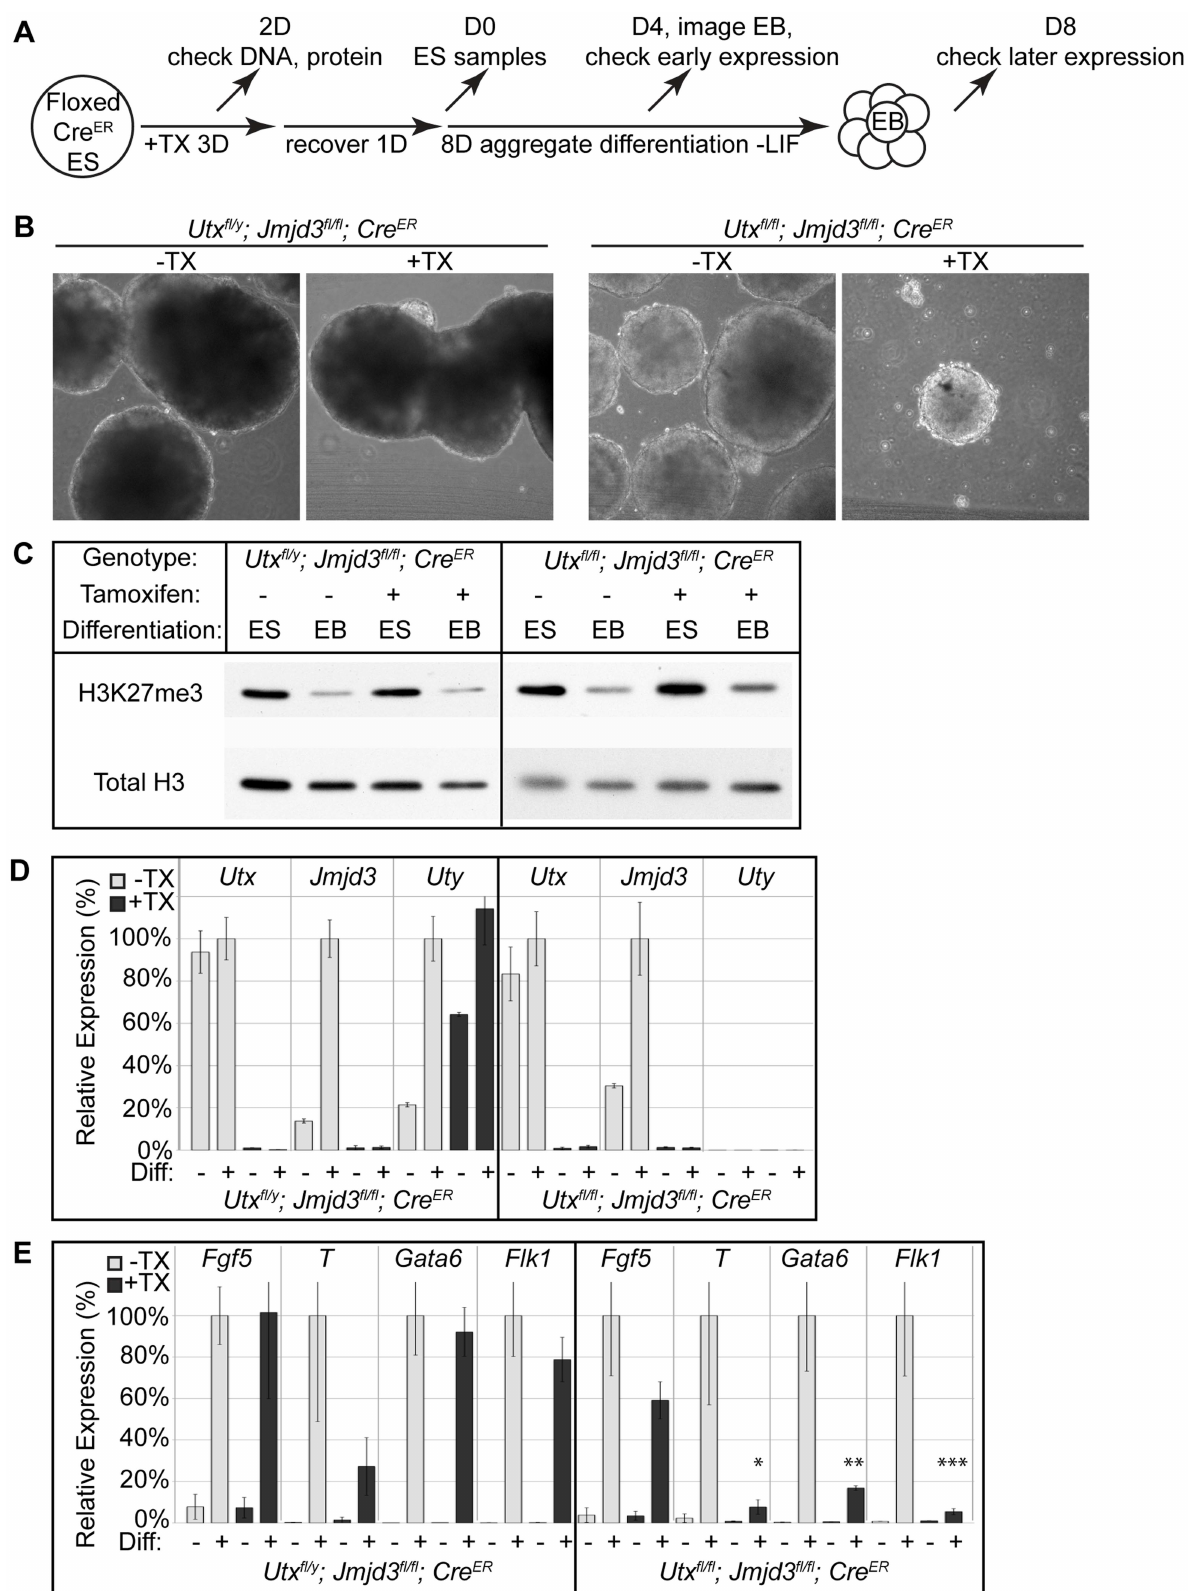
Figure 2. EB differentiation of male and female Utx and Jmjd3 mutant ES cell lines. (A) Utx fl/y ; Jmjd3 fl/fl ; Cre ER or Utx fl/fl ; Jmjd3 fl/fl ; Cre ER ES cell lines were left untreated ( 2 TX) or treated with tamoxifen for 3 days ( + TX), then differentiated in aggregate suspension culture (EB). (B) Images of day 4 EBs. (C) Histones were extracted from Utx fl/y ; Jmjd3 fl/fl ; Cre ER or Utx fl/fl ; Jmjd3 fl/fl ; Cre ER ES cells (Differentiation ES) or day 4 EBs (Differentiation EB) left